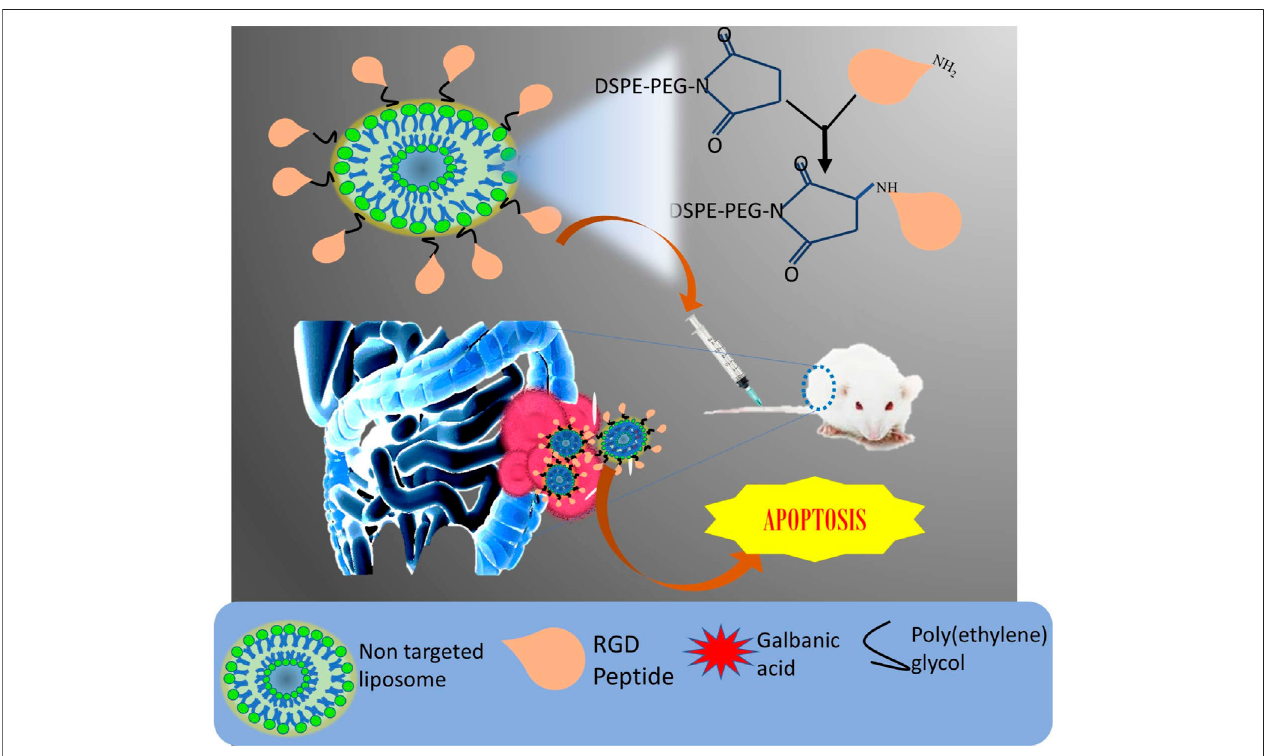
FIGURE 6 | Schematic representation of preparation of RGD-decorated liposome loaded with galbanic acid against colon cancer.